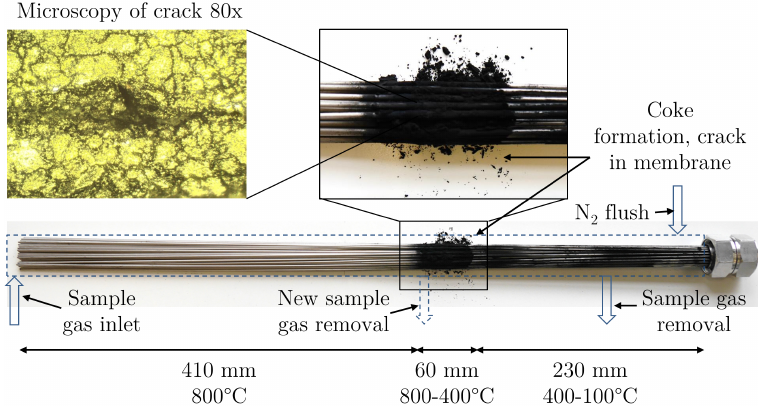
Figure 4. Photography of coke formation on membrane bundle and microscopy of membrane crack